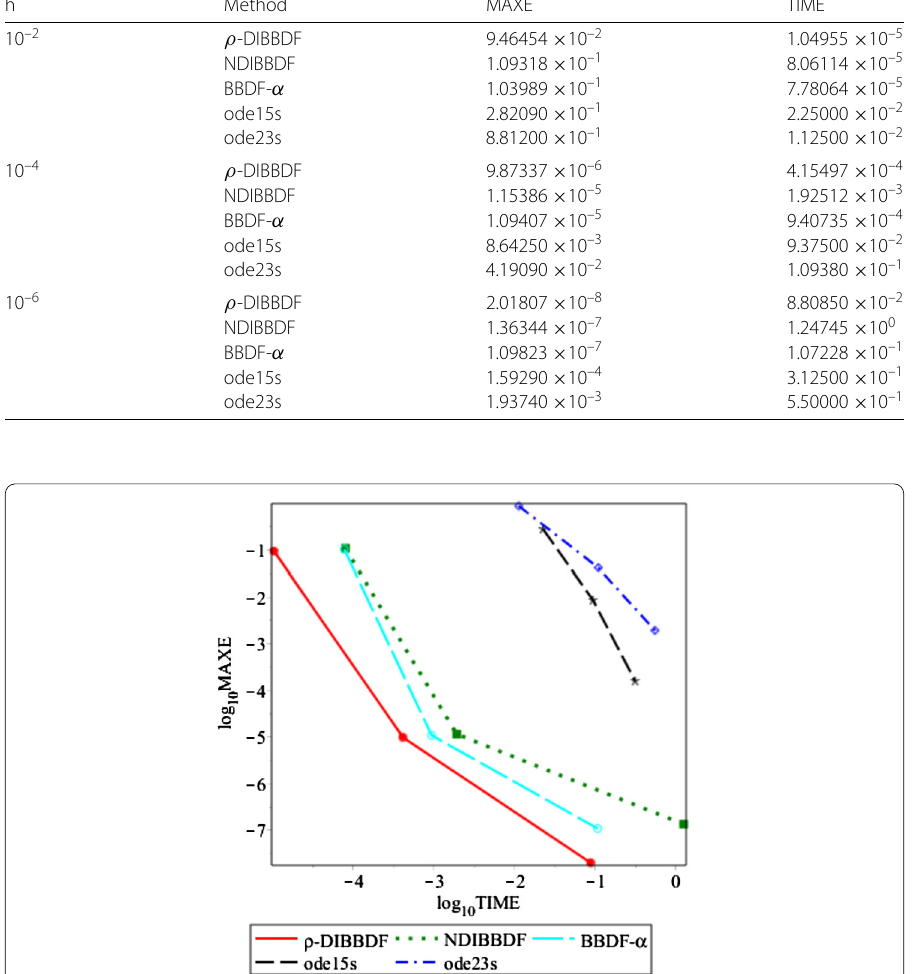
pharmacokinetics model of ODEs. For future research, ρ -DIBBDF may also be applied to other models arising in the